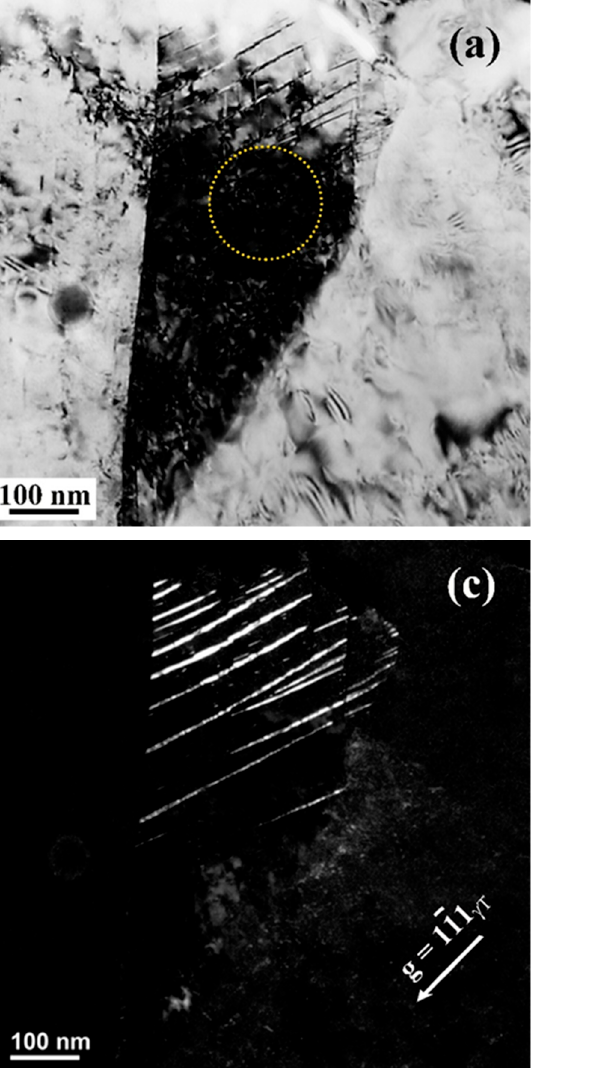
[011] / / [011] γ γ . γ : // [ 011 ] . γ : austenite T γ γ T